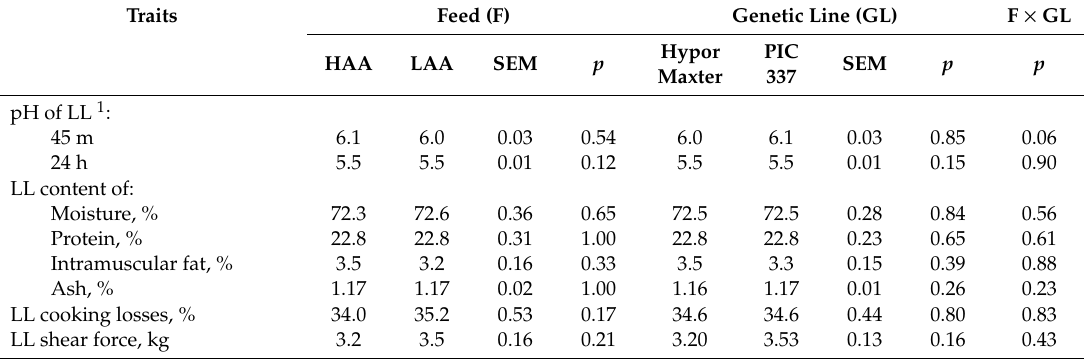
Table 6. Longissimus lumborum (LL) physical and chemical characteristics in barrows of two genetic lines fed high (HAA) or low indispensable amino acid feeds.